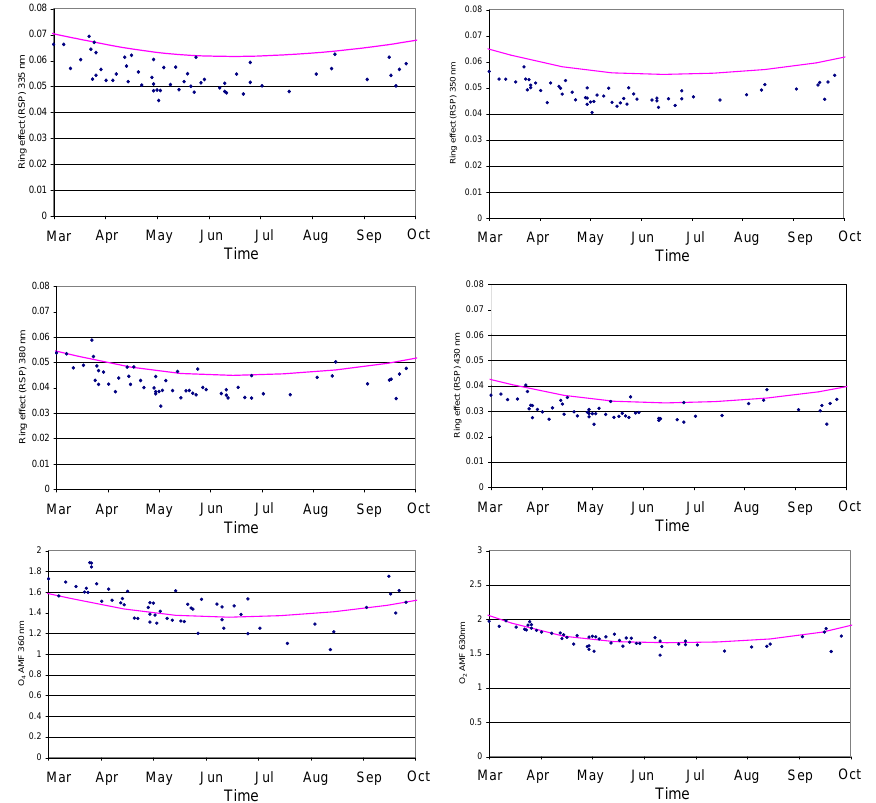
Fig. 5. Seasonal variation (March to October) of the Ring effect and O 2 and O 4 absorption over Beijing. The measurements include only cloud-free observations. The magenta lines represent the result of radiative transfer simulations (see Sect. 3) for aerosol-free conditions. For 630 nm the surface albedo was set to 10%; for all other wavelengths it was set to 5%.